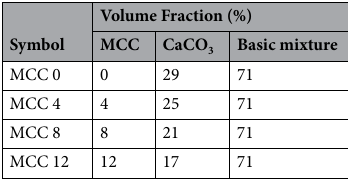
Table 1. Composition of the composites.